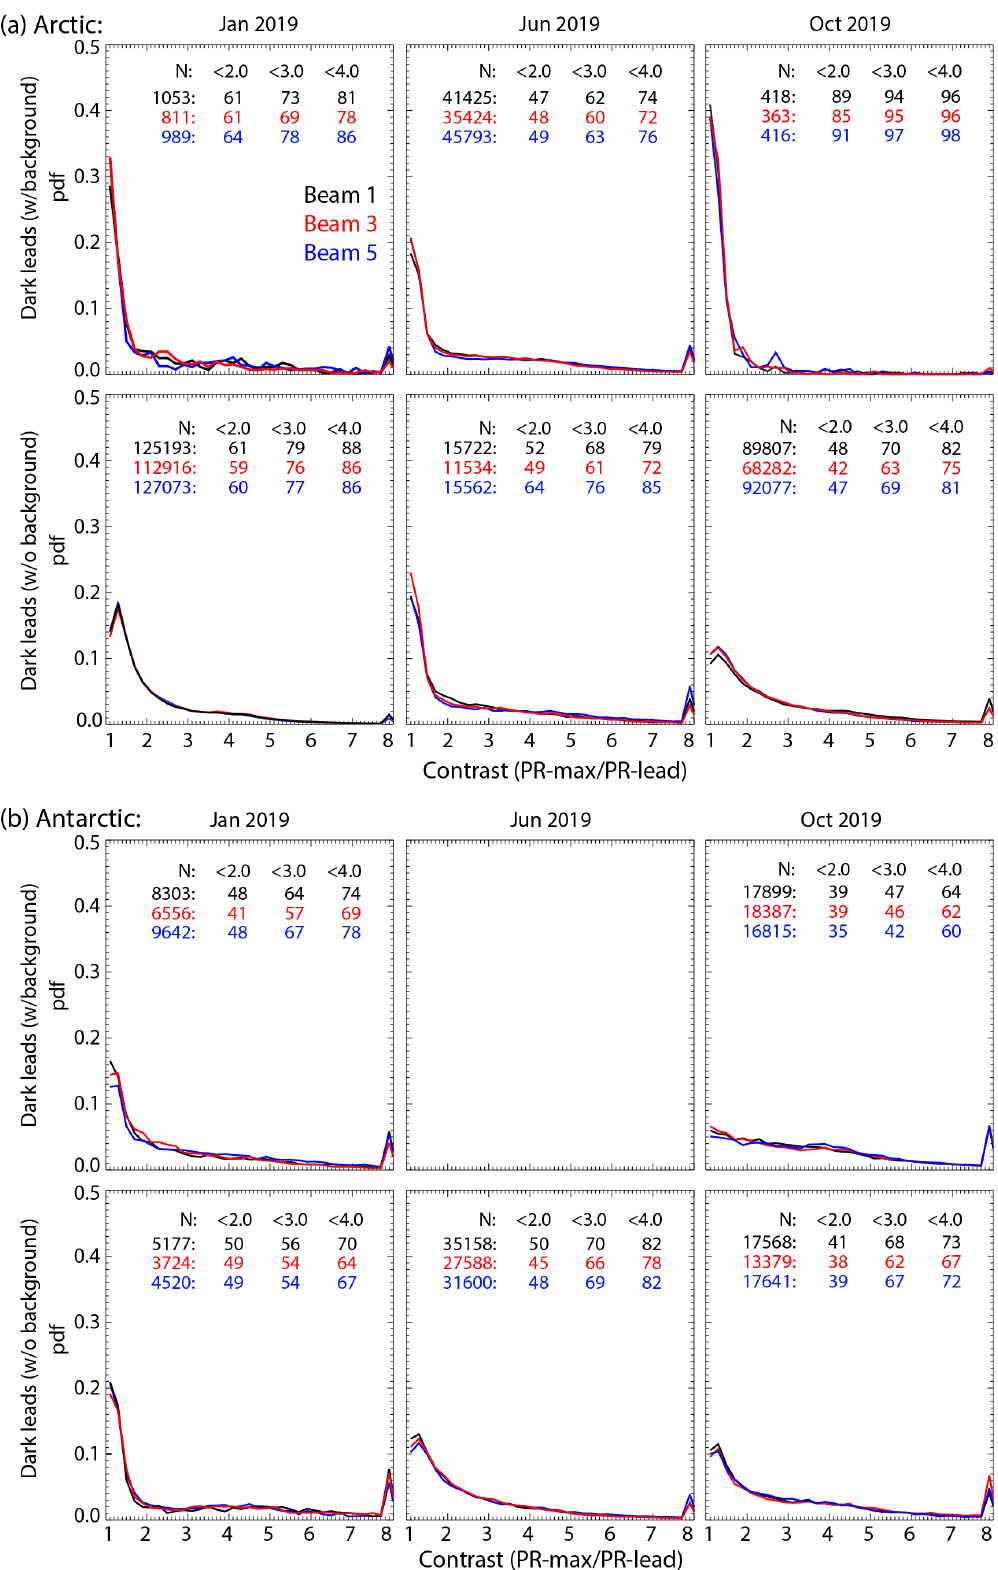
Figure 4. Contrast of lead photon rate (PR-lead) with surface segment with the highest photon rate (PR-max) within ± 20km of the “dark” lead for the months of January, June and October 2019. Numerical values show the number of surface height segments classified as dark lead and the percentage of the population with contrast (PR-leads / PR-max) < 2 . 0, < 3 . 0 and < 4 .